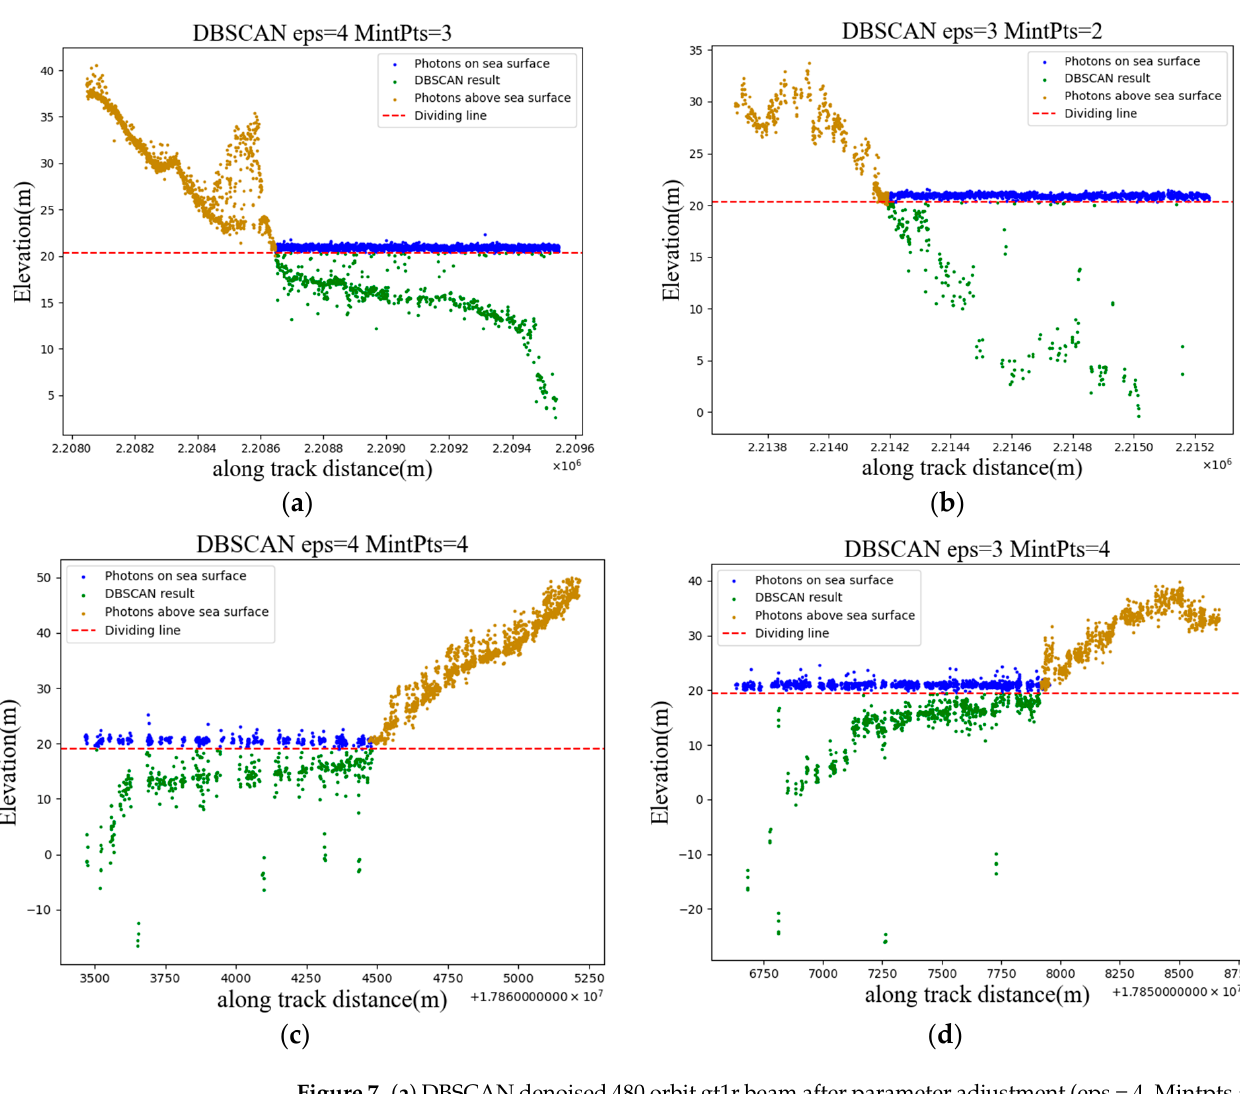
Figure 6. ( a ) DBSCAN denoising graph with “loose” parameter se tt ings (eps = 6, MintPts = 3); ( b ) DBSCAN denoising graph with “strict” parameter se tt ings (eps = 3, MintPts = 5).